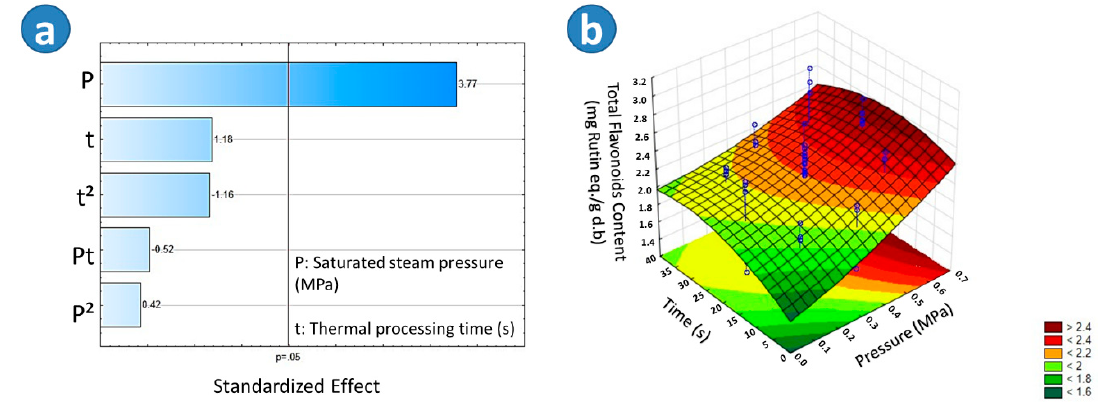
Figure 3. Effects of steam pressure “P” (MPa) and thermal processing time “t” (s) on the Total Flavonoids Content (TFC) of Blanched Swell-Dried (BSD) red beetroots. ( a ) The Pareto chart and ( b ) surface response plot are shown.